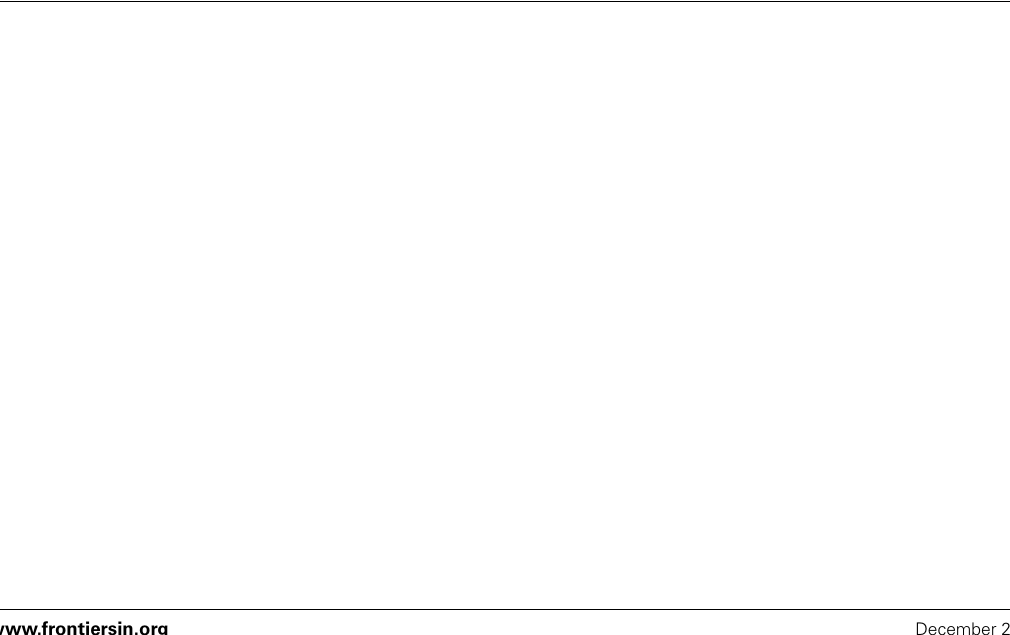
FIGUREA2 | Expression of Maf (A) and Zbtb7 (B) mRNA analyzed by TaqMan RT-PCR. Cells from thymi or spleens of mice with the indicated genotype were isolated and stained with PBS-57-loaded CD1d tetramers and